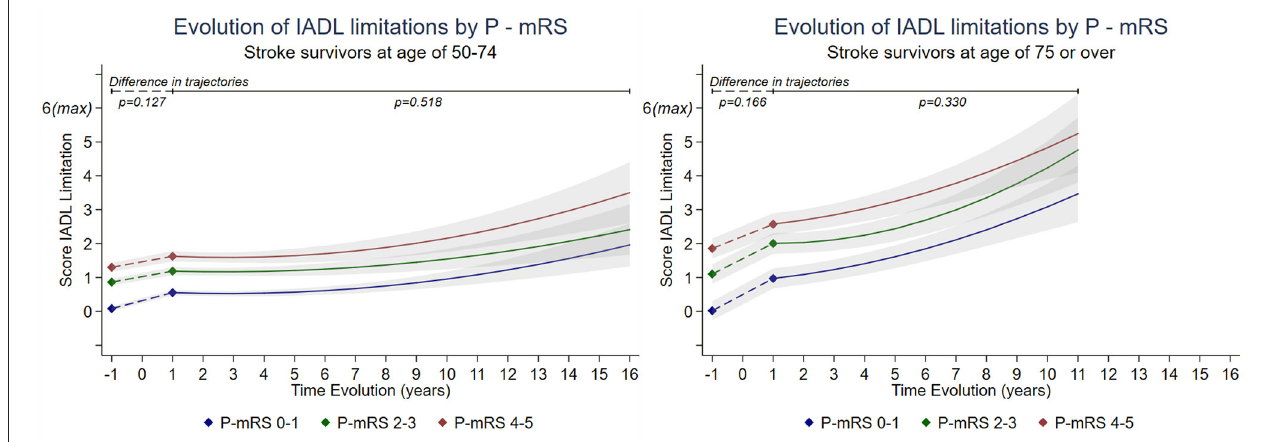
FIGURE 3 | Long-term trajectories of score of IADL limitations in stroke survivors by premorbid modified Rankin scale (P-mRS) stratified by age*. *Estimated from piecewise linear mixed model adjusted for socioeconomic variables, pre-stroke wave data collection, heath behaviors, BMI, and number of comorbidities. Breakpoint was set at 1 year post-stroke. Detailed changes in limitations between pre-stroke and 1 year post-stroke could not be modeled due to lack of information and was assumed linear for the sake of the analysis. IADL score range from 0 = no limitation to 6 = maximum limitation. Estimations are presented for a 16 year follow-up (corresponding to maximum follow-up with at least 5 participants by level of mRS) for population aged 50–74 years and a 11 year follow-up for those aged ≥ 75 years. Supplementary Table 5